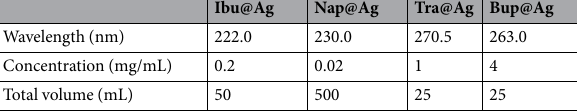
Table 1. Some details of the sustained release